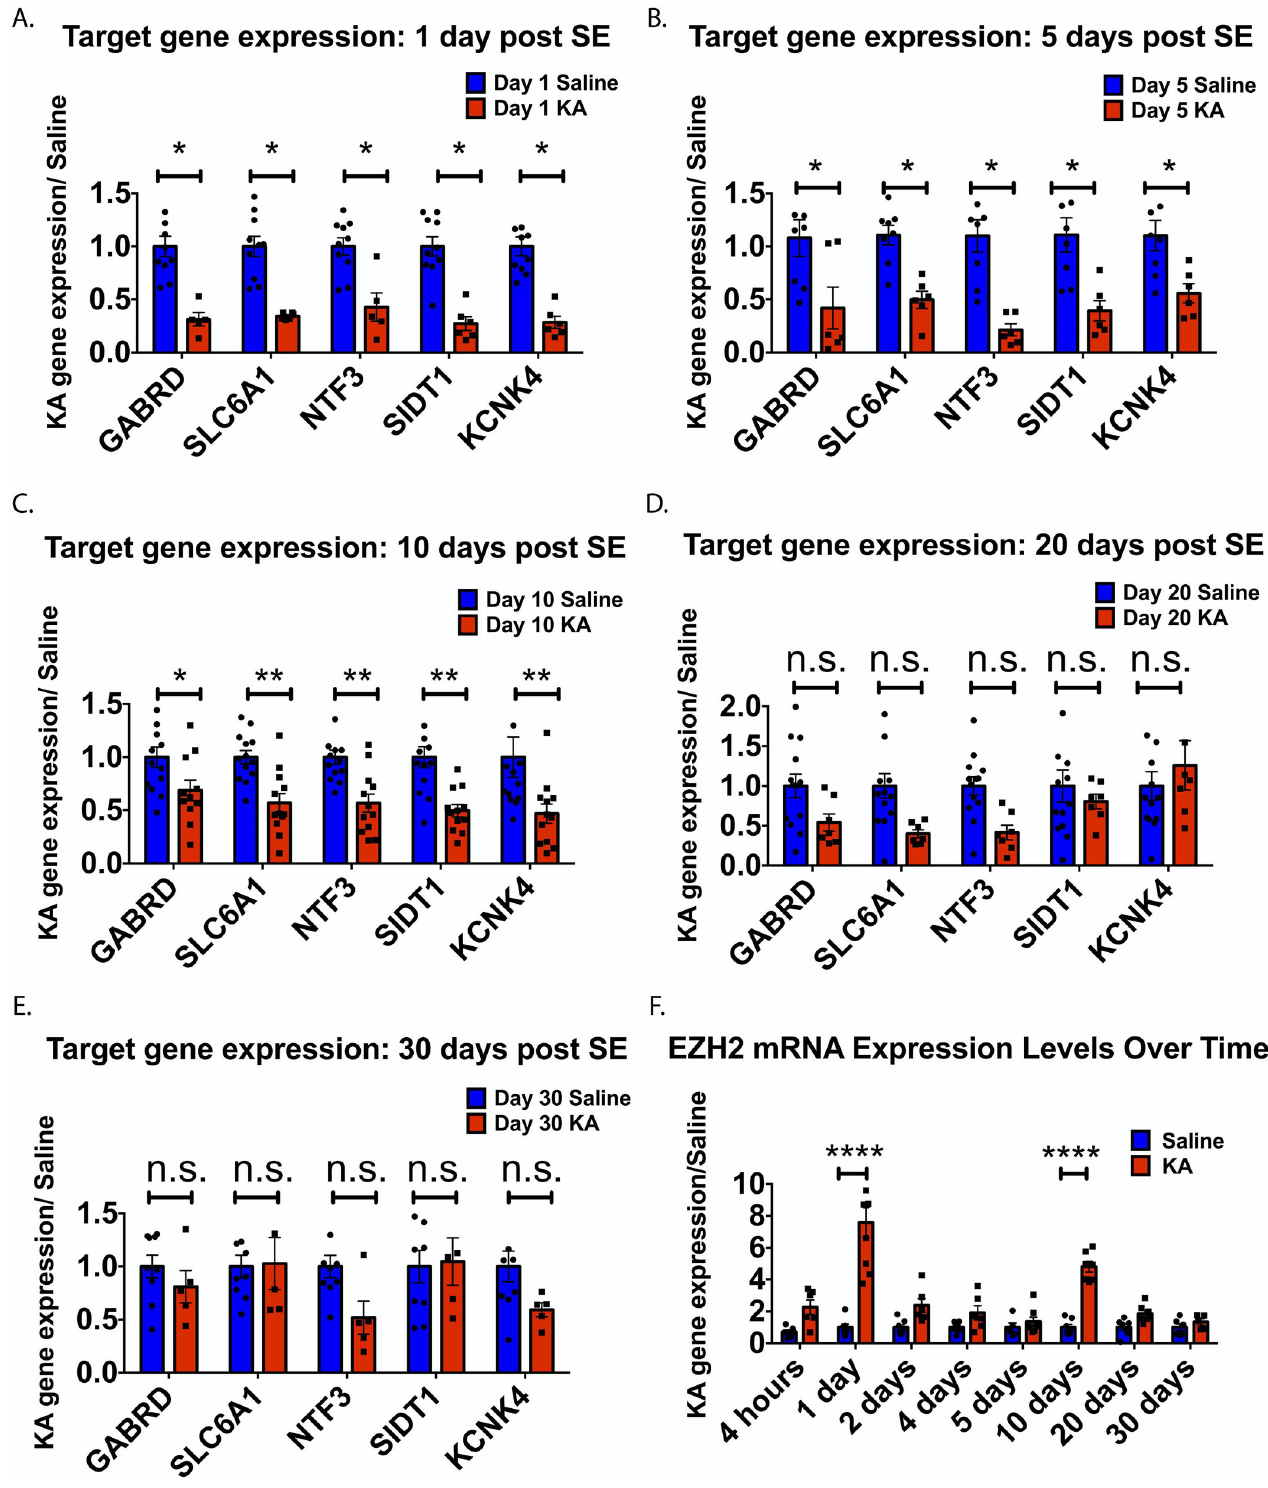
Fig 5. EZH2 mRNA levels exhibit early, transient increases after SE, while EZH2 target gene expression is down regulated out to 10 days. For panels (A-E), gene expression data for five tested EZH2 target genes are shown. All statistical tests were performed using multiple t-tests with Holm-Sidak correction for multiple comparisons; � p < 0.05, �� p < 0.01, ��� p < 0.001, ���� p < 0.0001. n = 3–13 animals for saline and n = 5–13 animals for KA conditions. Target genes show significant down regulation after SE out to 10 days (A-C), with the exception of SLC6A1 and KCNK4 showing no difference compared to saline